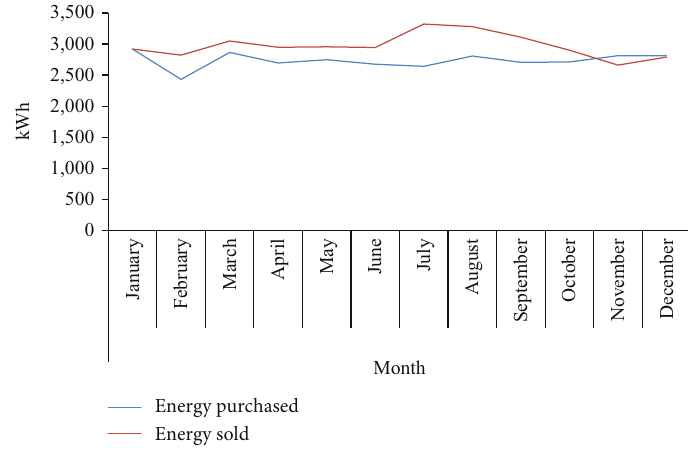
Figure 32: Grid sales against purchases of the hybrid PV-grid small-grid system with storage.